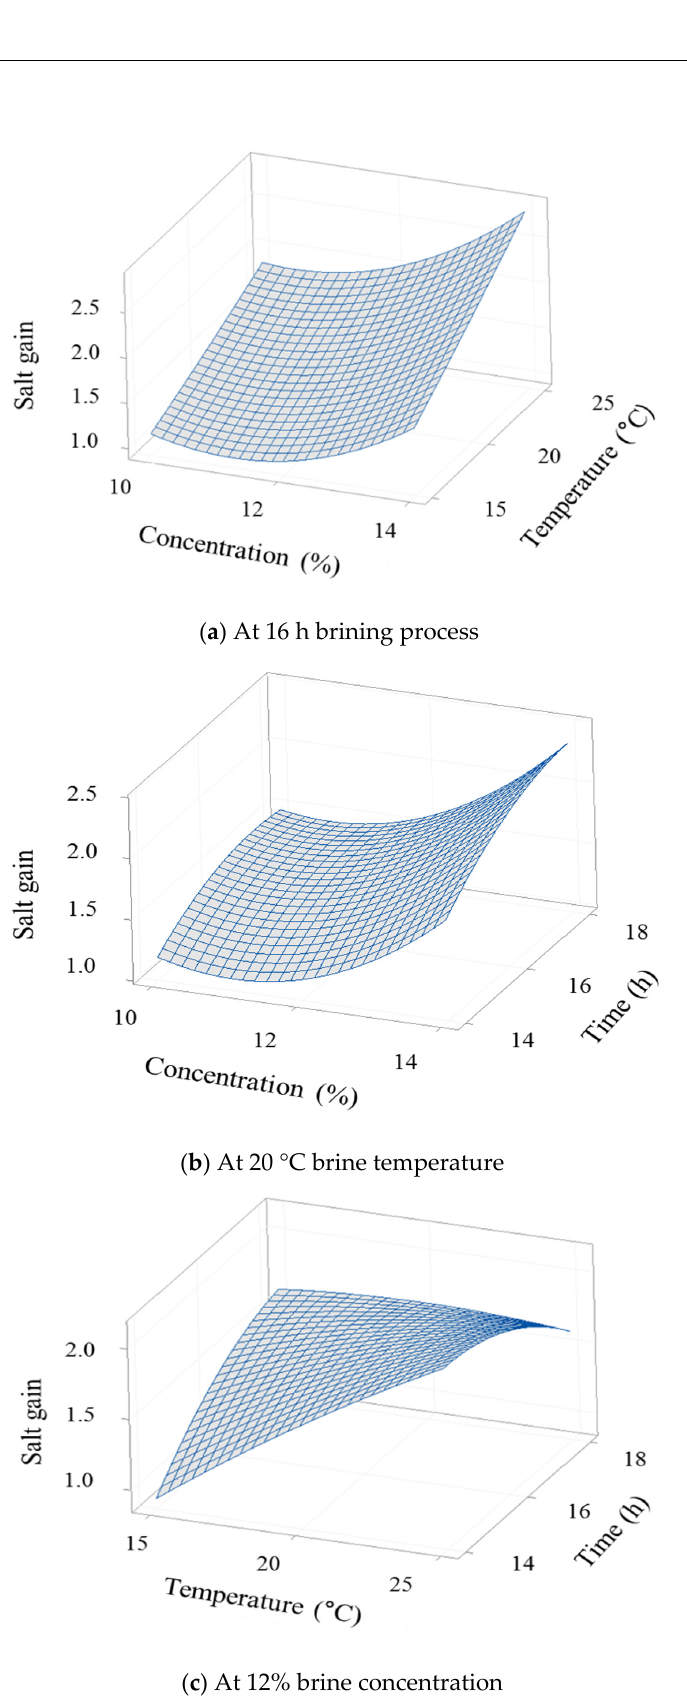
Figure 2. The 3D response surface plots for the salt gain during brining process of Kimchi cabbage as a function of ( a ) salt concentration and solution temperature, ( b ) salt concentration and immersion time, ( c ) solution temperature and immersion time.